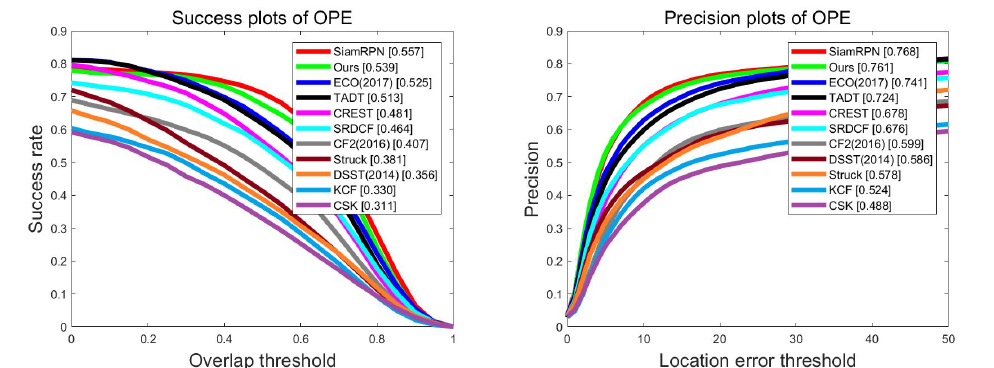
Figure 12. Success and precision rates on the UAV-123